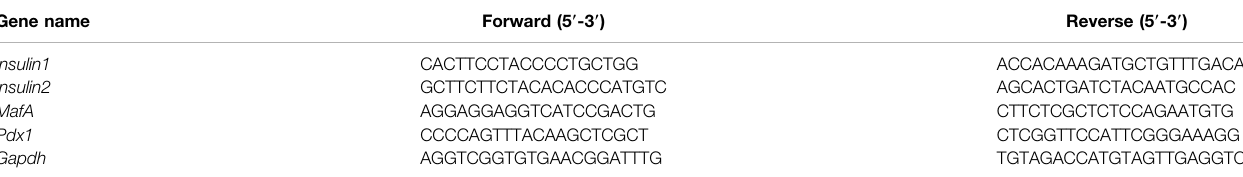
TABLE 1 | Primers used in the quantitative real-time PCR